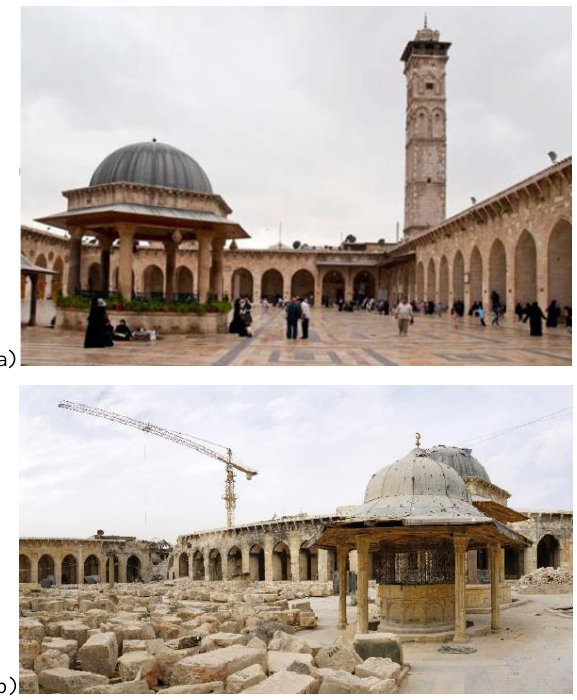
Figure 13: The Minaret of the Great Umayyad Mosque before the war and after the war.